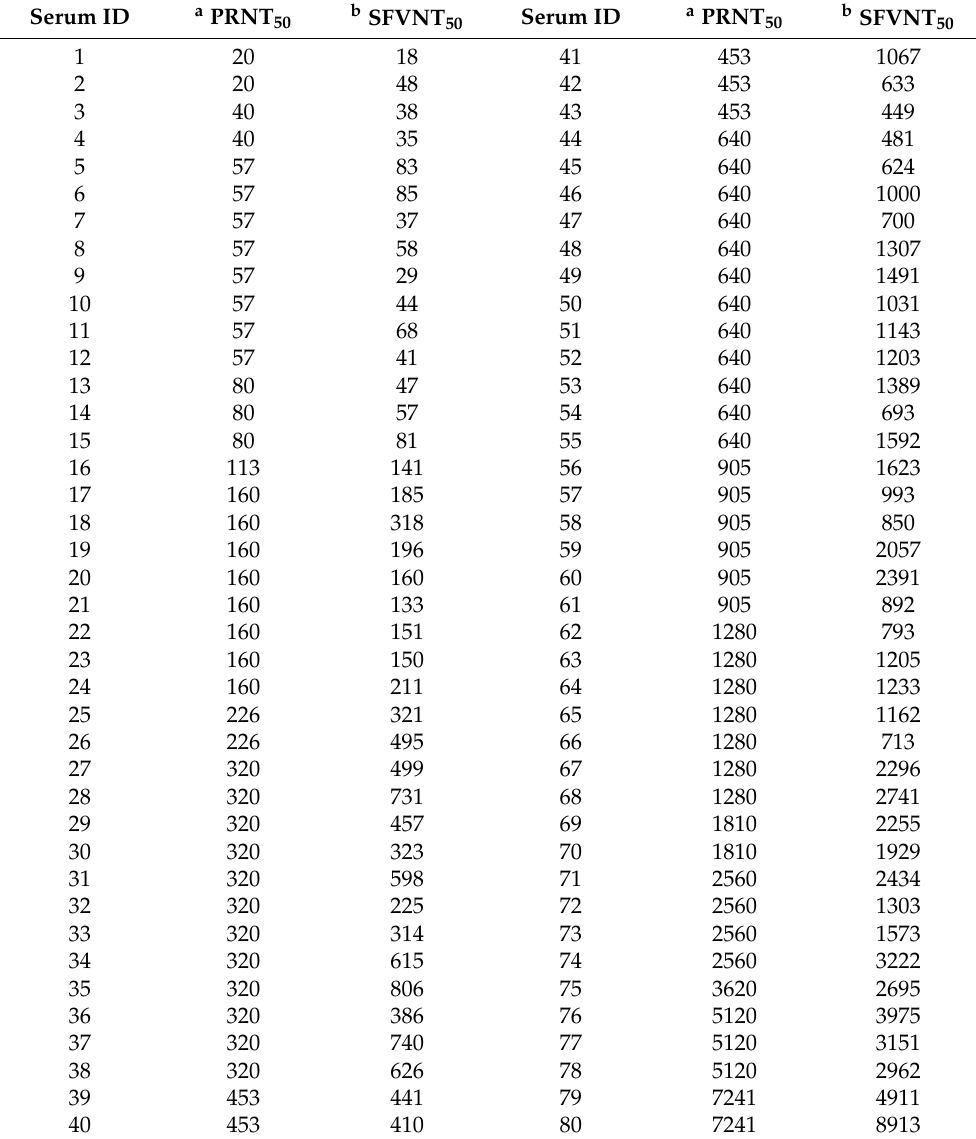
Table 1. Comparison of neutralization titers of vaccinated subjects’ sera/plasmas analyzed by the PRNT and